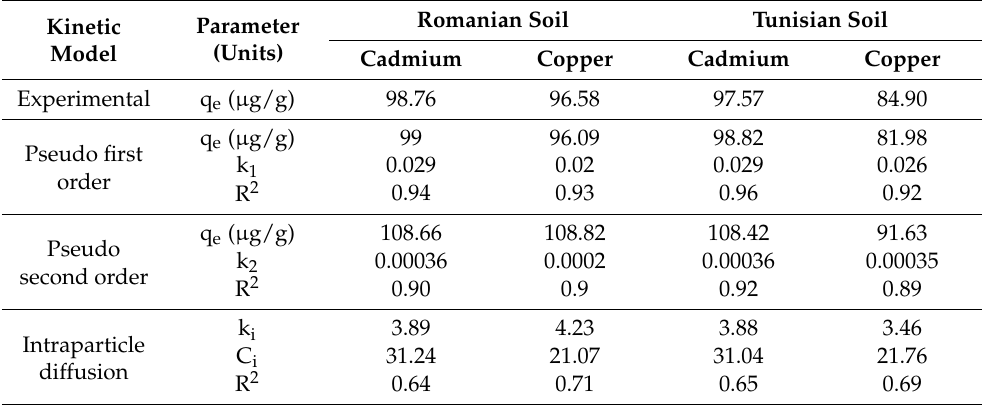
Table 2. Main properties of Tunisian and Romanian soils.